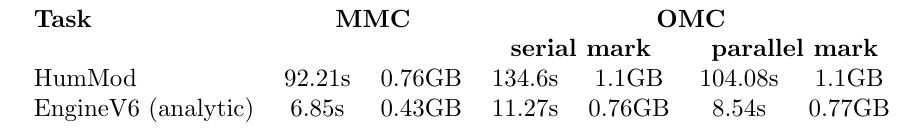
Table 4: Compiler performance, checkModel() on large models, time spent and memory consumption.